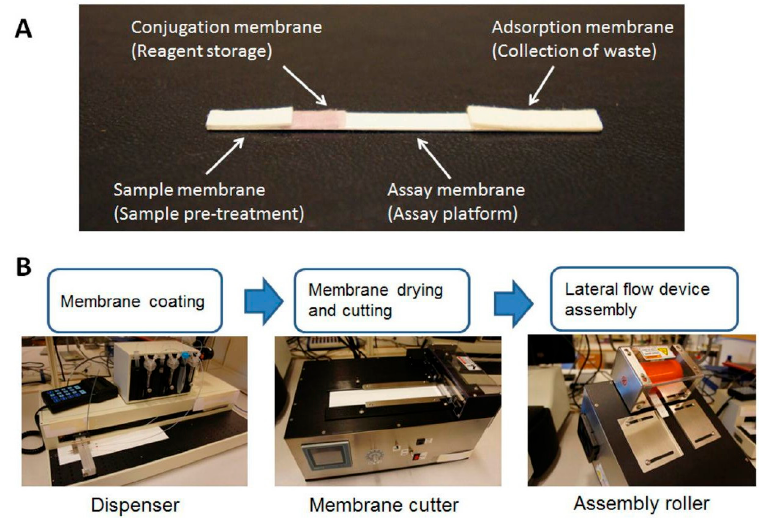
Figure 6. ( A ) Schematic diagram showing various membranes components and theirs functions in the design of the lateral-flow biosensing assay test. ( B ) Manufacturing processes for lateral flow tests includes: membrane coating, membrane drying and cutting, lamination and device assembly [38].